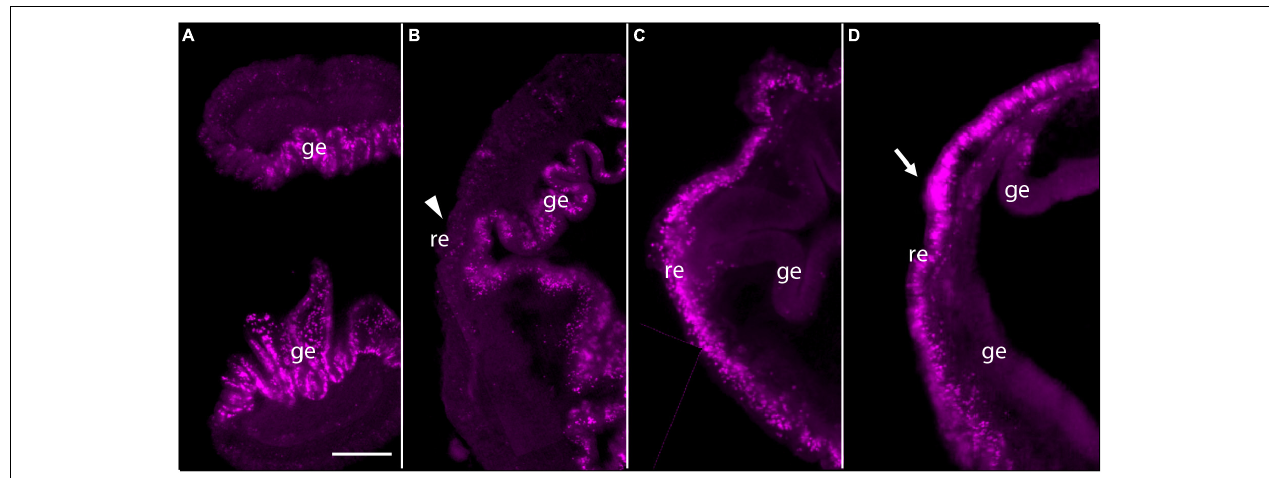
FIGURE 3 | Pulse-Chace experiments using EdU. (A) Uninjured animals were incubated with EdU and dividing cells were detected. Most dividing cells were observed in the gut epithelium. (B) Uninjured animals were incubated with EdU, then cut and allowed to regenerate for 48 h. There were very few labeled cells in anterior regenerating tissue (arrowhead), but many labeled cells in the gut epithelium. (C) Animals were labeled with EdU at 3 days post-amputation (dpa) and dividing cells were detected. Labeled cells were detected in and around the epithelium of regenerating tissues. (D) Animals were labeled with EdU at 3 dpa and allowed to regenerate for 24 h. Labeled cells appeared to remain in the anterior portion of the regenerating tissue after 24 h. The mass of labeled cells enlarged, and the regenerating blastema appeared to start forming a small proboscis (arrow). The left side is the anterior portion of regenerating tissues in all panels. Scale bar = 0.3 mm and all samples are 3–4 mm in size. Acquired microscopic data were composed into a single image for each sample. ge, gut epithelium; re, regenerating